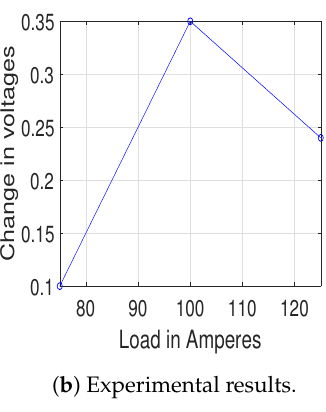
Figure 12. Load vs. change in voltage [24].